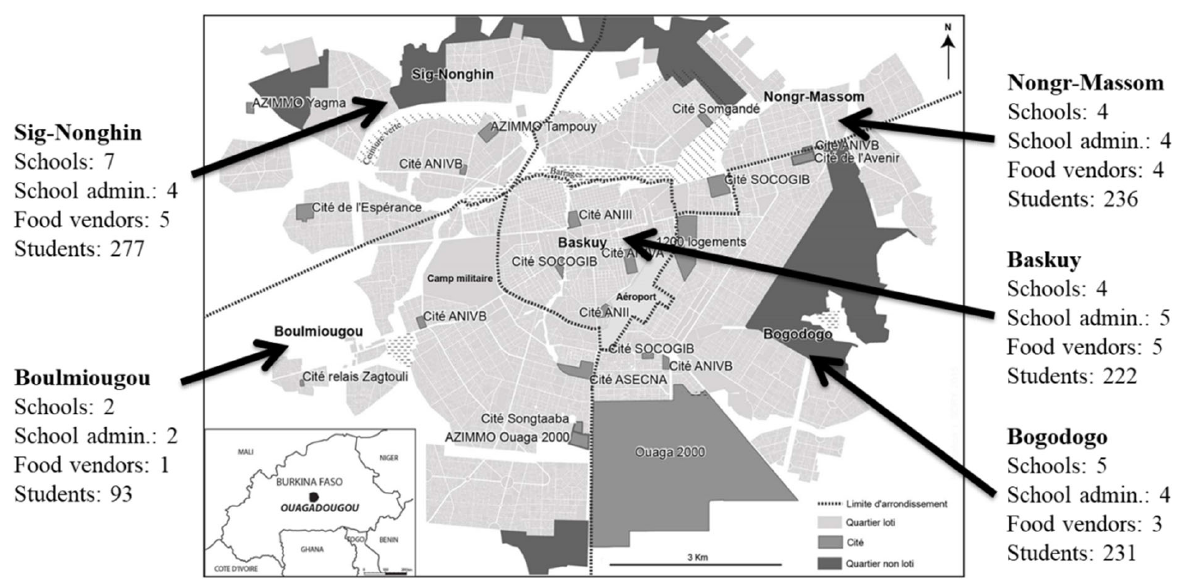
Figure 1. Map of Ouagadougou and the distribution of the three data sources (school administrators, food vendors and in ‐ school adolescents) across the five city districts (map from [20]).